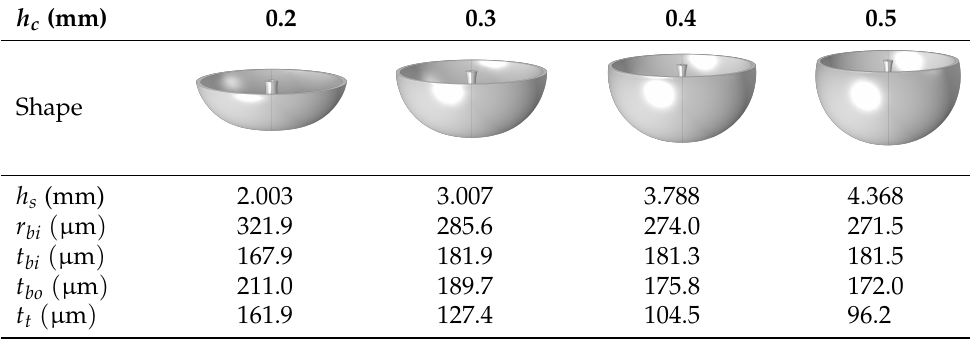
Table 4. Shape and key shape parameters of microhemispherical shells at different groove